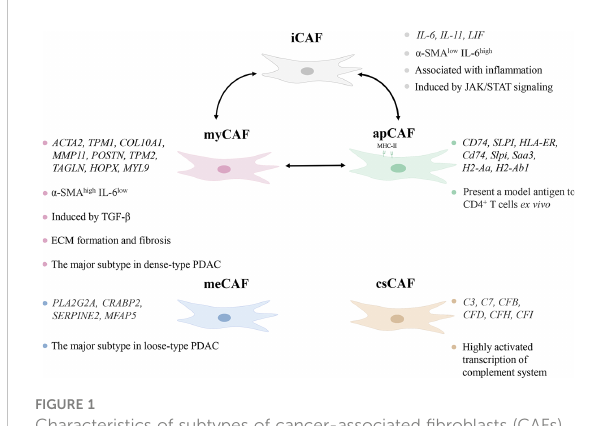
FIGURE 1 Characteristics of subtypes of cancer-associated fi broblasts (CAFs). The different subtypes of CAFs show heterogeneity in distribution, marker genes, and pathways in the tumor microenvironment. iCAF, in fl ammatory CAF; a -SMA, a -smooth muscle actin; IL-6, interleukin-6; myCAF, myo fi broblastic CAF; TGF- b , transforming growth factor- b ; ECM, extracellular matrix; PDAC, pancreatic ductal adenocarcinoma; apCAF, antigen-presenting CAF; meCAF, CAF with a highly activated metabolic state; csCAF complement- secreting